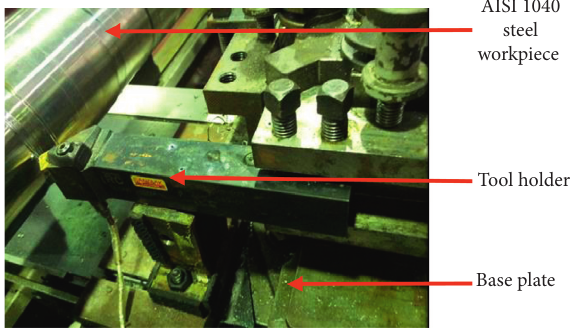
Figure 3: Surfacing the